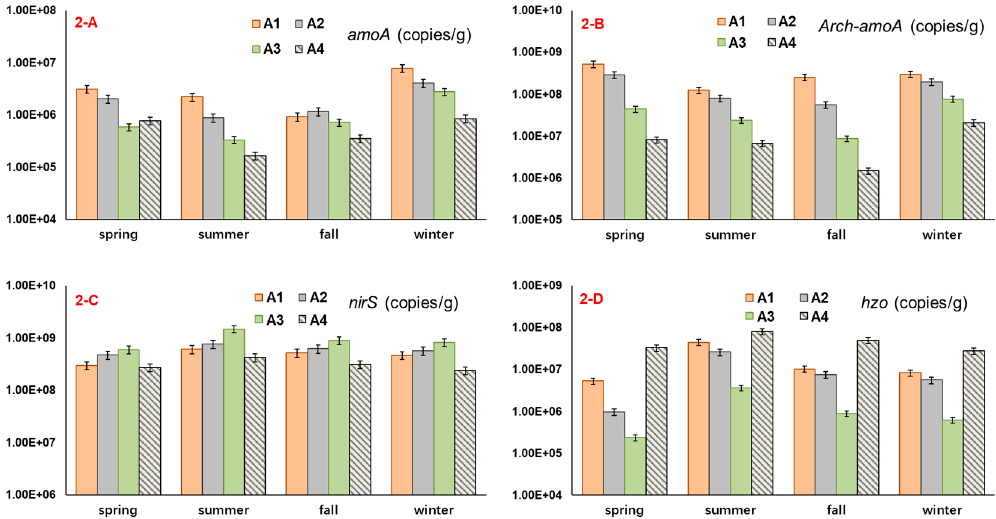
Figure 2. The average value of nitrogen-transforming gene abundances in each lake region during four seasons. 2-A : amoA gene, 2-B : Arch - amoA gene, 2-C : nirS gene, 2-D : hzo gene.